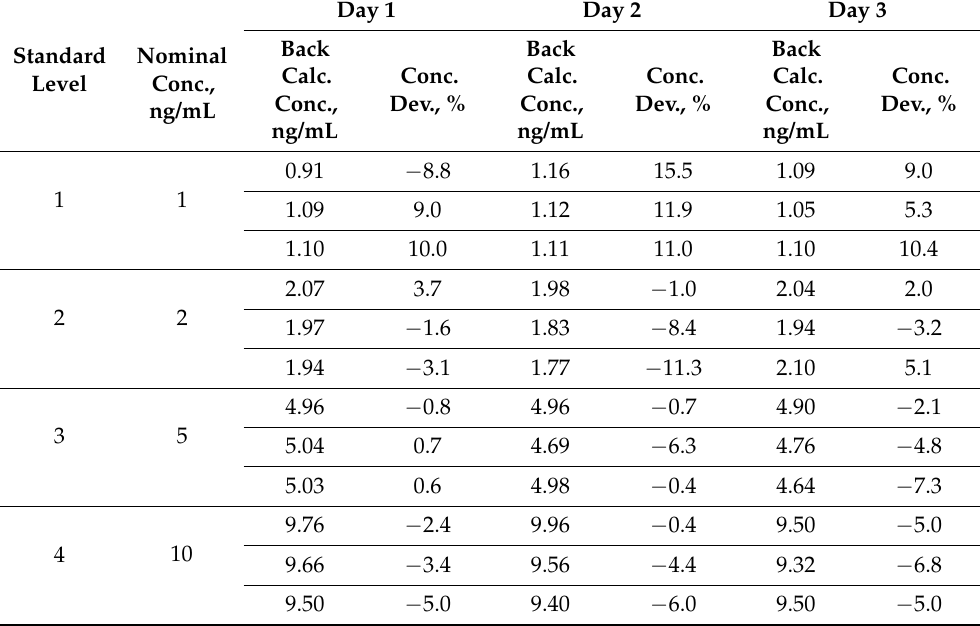
Table A4. Calibration curve data for